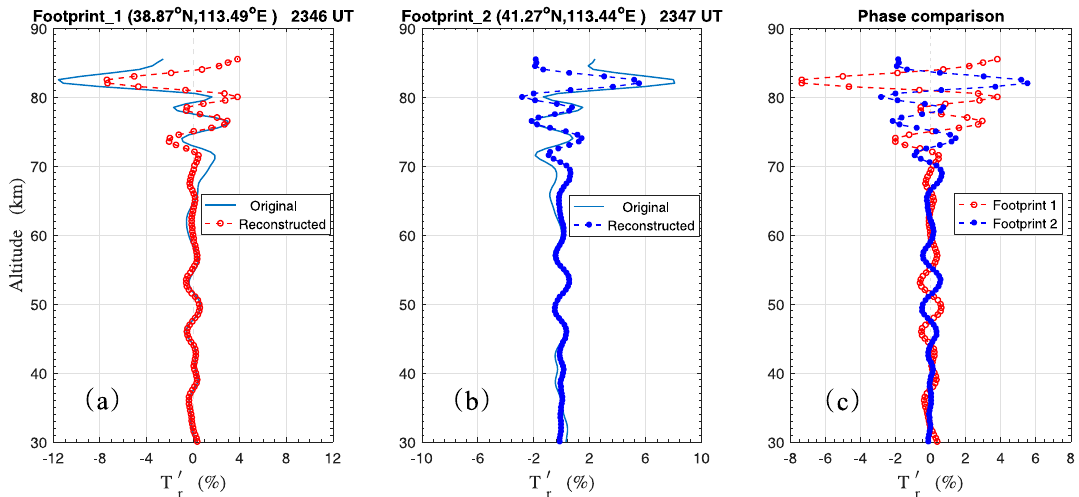
Figure 7. Wave structures observed by TIMED/SABER at footprint 1 (38.87° N, 113.49° E) and footprint 2 (41.27° N, 113.44° E) on 30 May 2012. ( a ) The relative temperature perturbation (solid line) observed at footprint 1 and the reconstructed AGW profile (dashed line with circles) by wavelet filter. ( b ) The relative temperature perturbation (solid line) observed at footprint 2 and the reconstructed AGW profile (dashed line with dots) by wavelet analysis. ( c ) Phase comparison between AGW propagations observed at the two footprints.